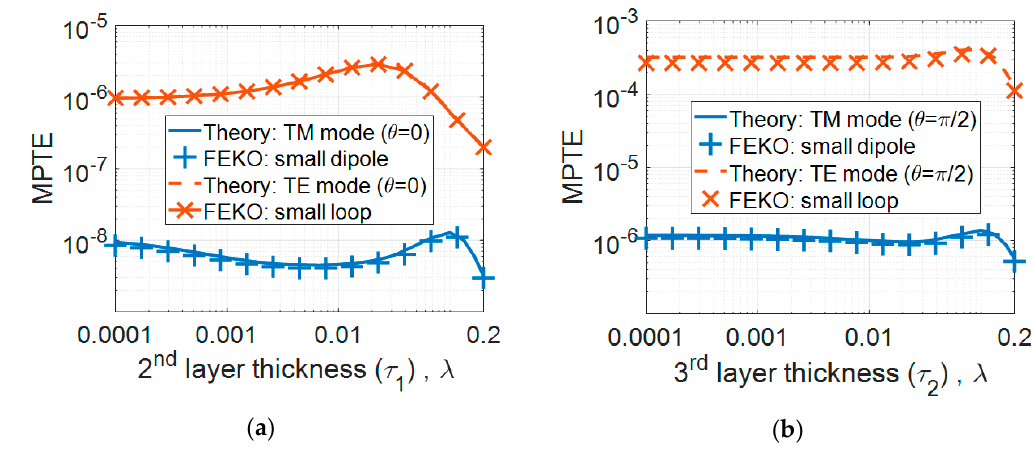
Figure 3. Maximum power transfer efficiency (MPTE) results using the derived theory and FEKO simulation according to ( a ) the thickness of the insulting layer ( τ 1 ) and ( b ) the thickness of the head layer ( τ 2 ).